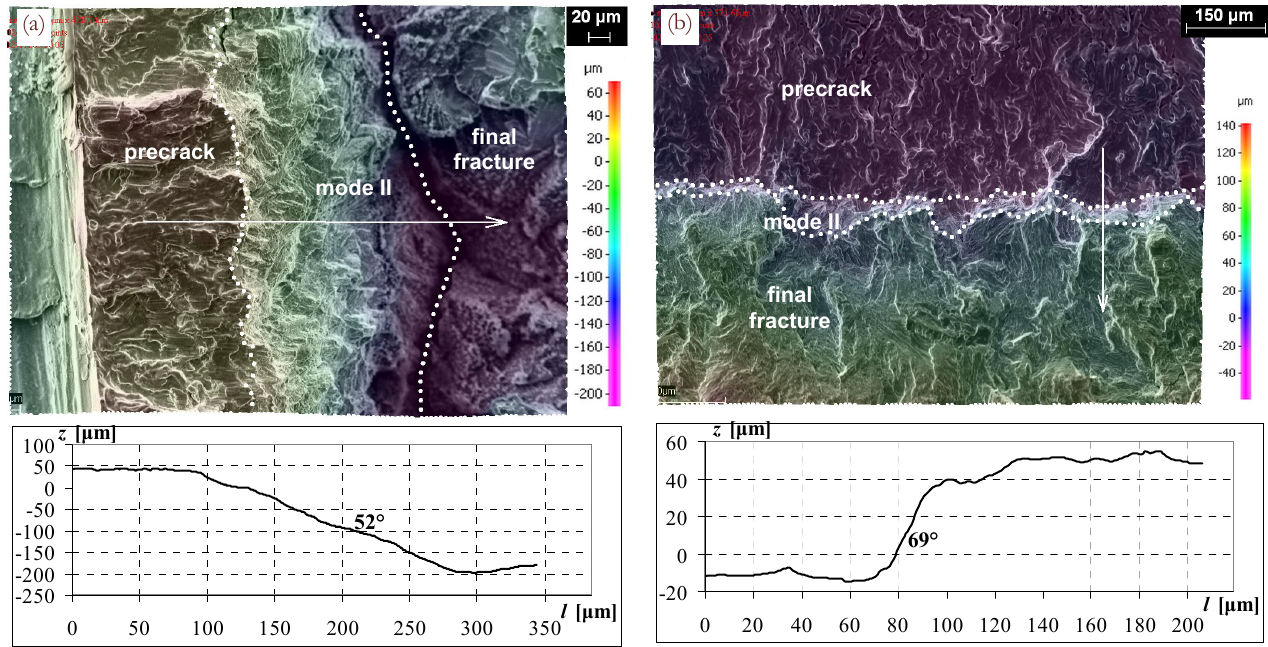
Figure 2: Mode II in ferritic-pearlitic steel, cylindrical shear specimen (a), compact-tension shear specimen (b). The white arrow defines the profile showed below and is parallel to the applied shear direction.